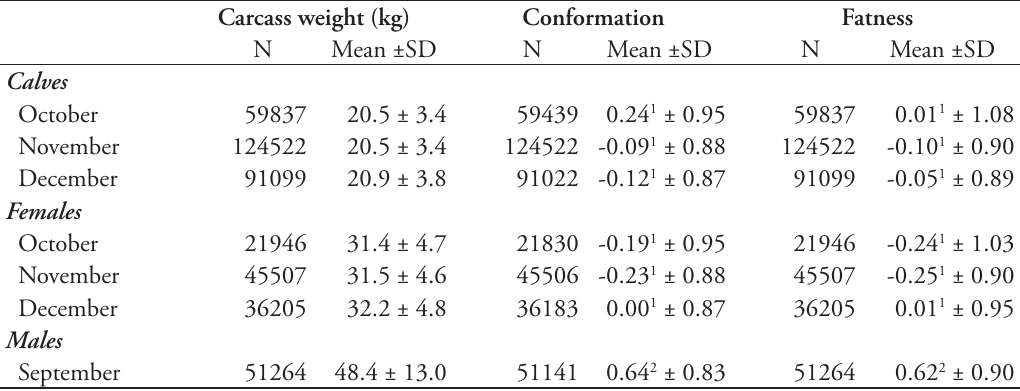
Table 1. Number of reindeer carcasses, means and standard deviations (SD) of carcass weights, and normal scores for conformation and fatness classifications of calves, females and males during the selected slaughter periods, divided on months. The figures are based on data from commercial reindeer slaughter in Sweden from 1994 to 2007, representing all the 51 herding districts in